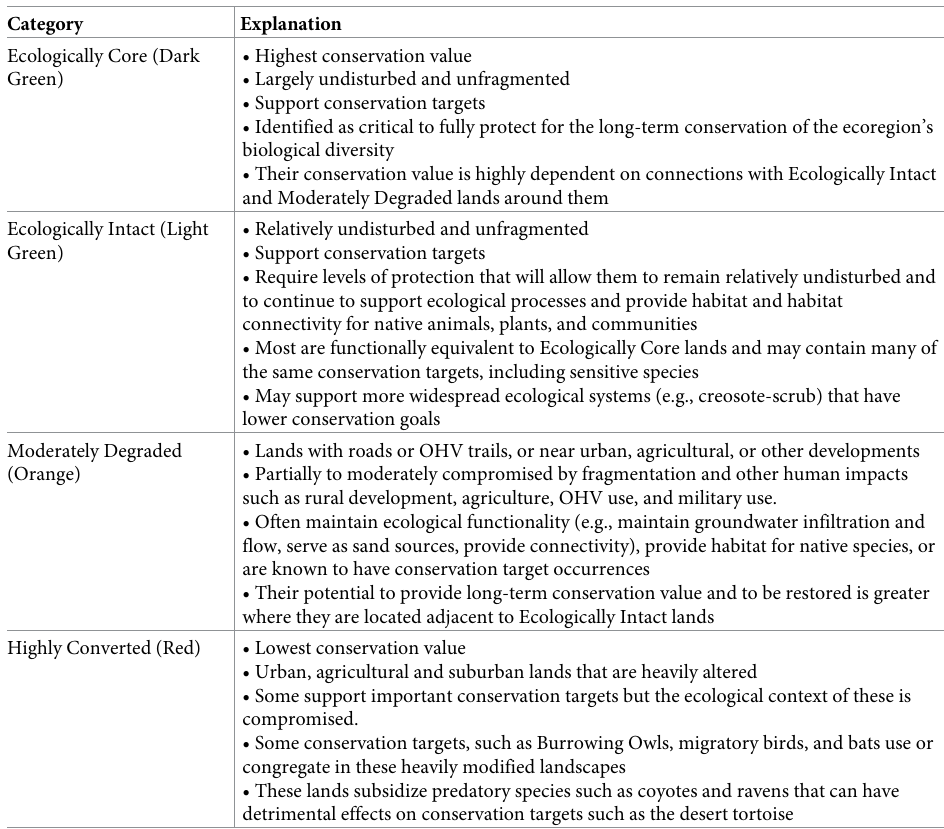
Table 2. Definition of conservation value